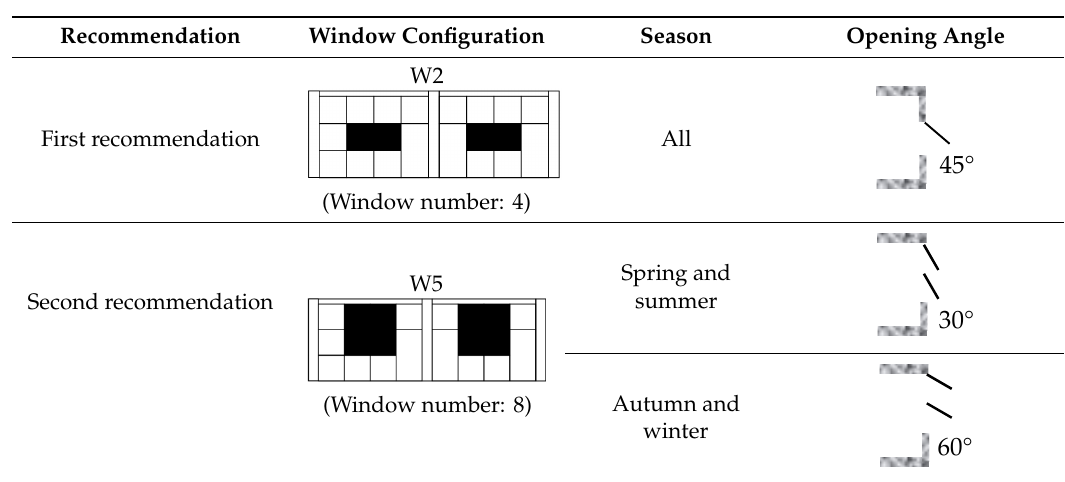
Table 4. Recommended awning window configuration and opening angle.